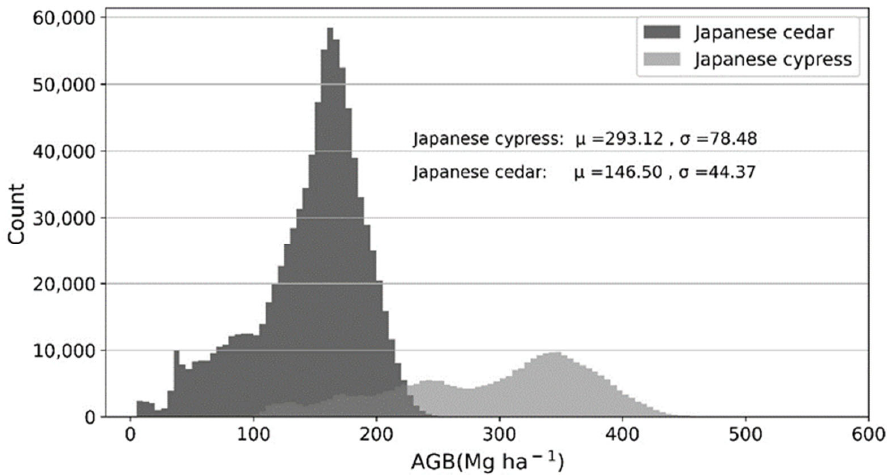
Figure 8. The distributions of aboveground biomass (AGB) in the targeted cities. Data is based on a 20 m resolution and AGB bins with a width of 5 Mg ha − 1 . Values for each species are means ( µ ) and standard deviations ( σ ).